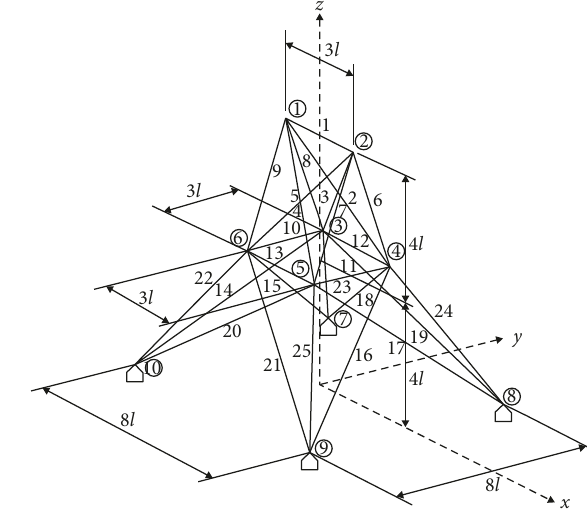
Figure 4: The experimental result of f